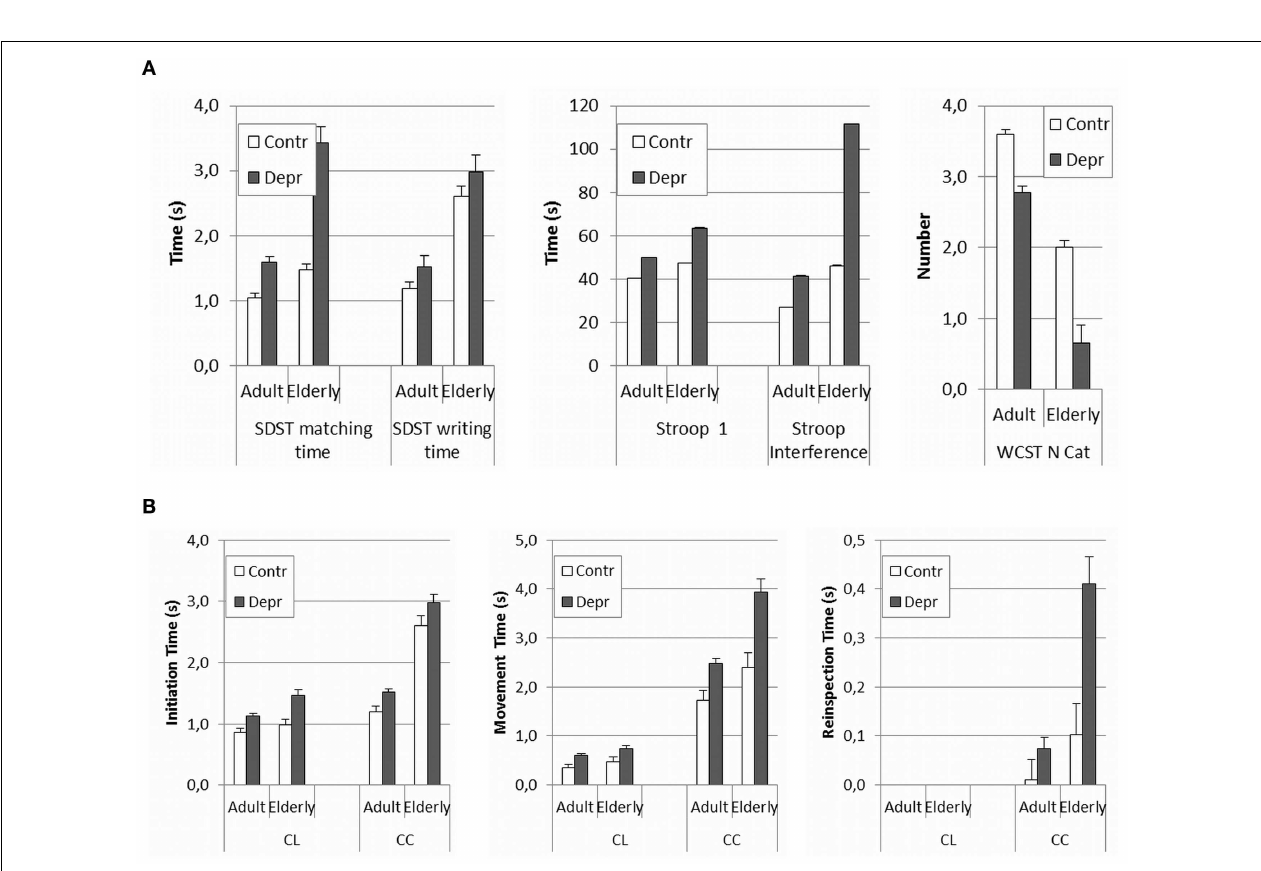
of just four lines, whereas with the adults a task with eight lines was used. To make the results comparable, recalculations were made for the adult scores based on the mean time for four lines. Separate times for each line were